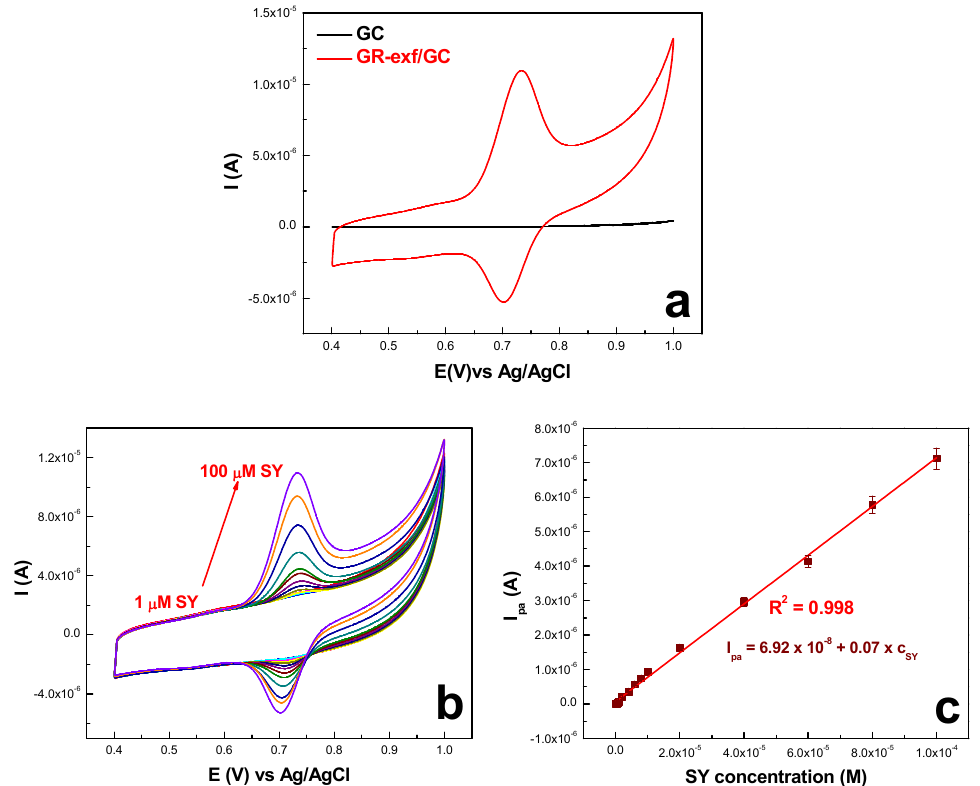
Figure 5. ( a ) Cyclic voltammograms recorded with: bare GC (black line) and GR-exf/GC (red line) in pH 6 PBS solution containing 100 µM SY; ( b ) CVs recorded with GR-exf /GC-modified electrode in PBS (pH 6) containing different SY concentration (1–100 µM), scan rate 10 mV/s; ( c ) corresponding calibration curve (peak intensity vs. SY concentration) . The use of an amperometric method (+ 0.75 V applied potential) led to better results, as can be seen in Figure 6. In this case, the SY linear concentration range was from 0.028 to 30 µM (regression equation I pa = 6.17 × 10 −9 + 0.02 × C SY ; R 2 = 0.998), and the detection limit (0.0085 µM) was lower by comparison with that obtained from CV measurements (0.303 µM).